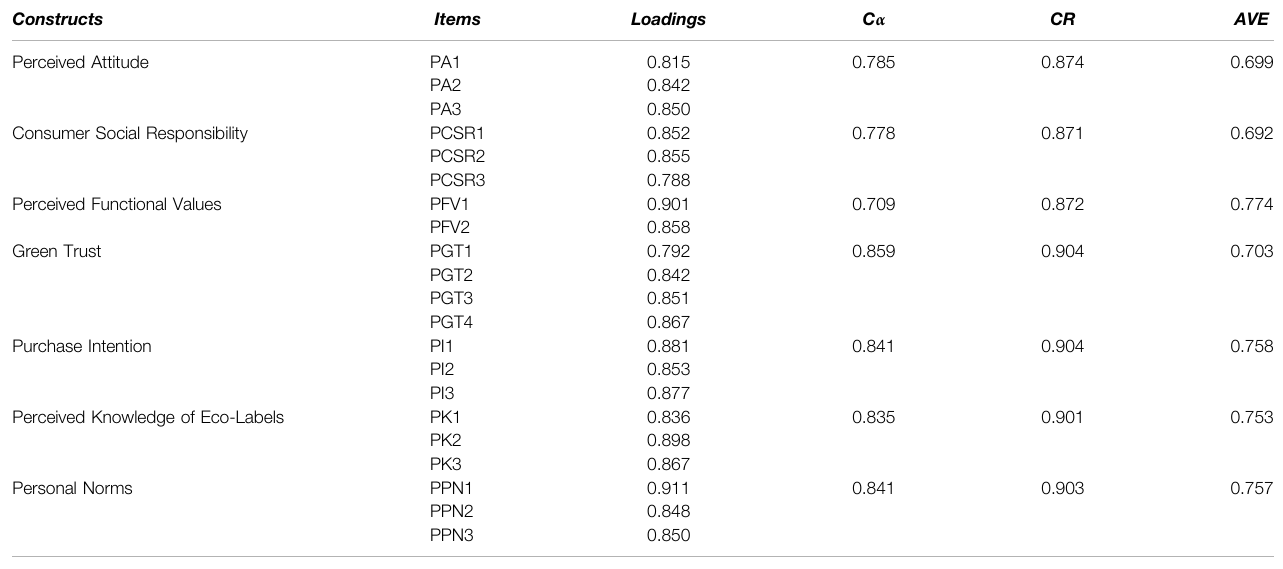
TABLE 1 | Reliability and validity analysis.